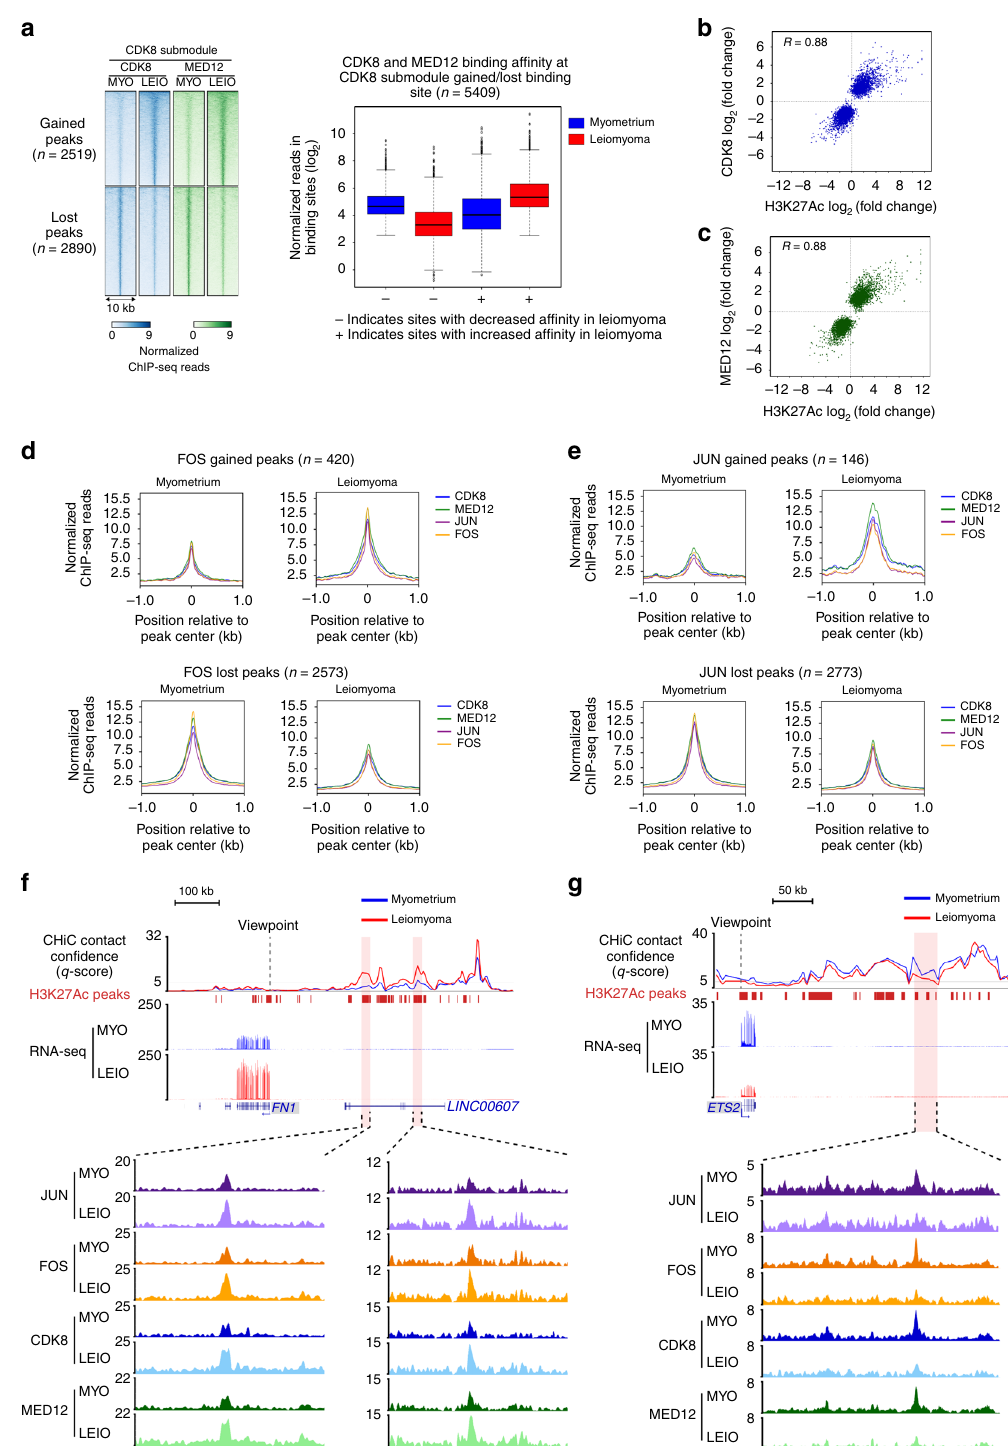
Fig. 5 CDK8 subcomplex chromatin occupancy correlates with changes in enhancer acetylation. a Heat maps of normalized CDK8 and MED12 ChIP-seq reads at differentially bound sites in myometrium vs. leiomyoma (left panel). Heat maps represent average signal of fi ve biological replicates. Right panel shows box and whisker plot of normalized reads at CDK8 and MED12 co-bound sites that show enrichment or depletion of both factors. Plots of sites with depleted ( − ) and enriched ( + ) CDK8 submodule signal are shown separately. Centerline represents the median, bounds of box represent the interquartile range (IQR) and whiskers are 1.5 × IQR. b , c Scatter plots of fold change in H3K27Ac signal against fold change in CDK8 ( b ) and MED12 ( c ) at enhancers with enriched or depleted CDK8 and MED12 binding. R represents the Pearson ’ s correlation coef fi cient. d , e Tag density plots of CDK8, MED12, JUN, and FOS ChIP-seq enrichment pro fi les at FOS ( d ) and JUN ( e ) enhancer binding sites in myometrium and leiomyoma. f , g AP-1 subunits (JUN and FOS) and CDK8 submodule (CDK8 and MED12) binding pro fi les at FN1 ( f ) and ETS2 ( g ) associated genomic loci. Myometrium and leiomyoma enhancer-promoter contacts and RNA-seq genomic tracks are also